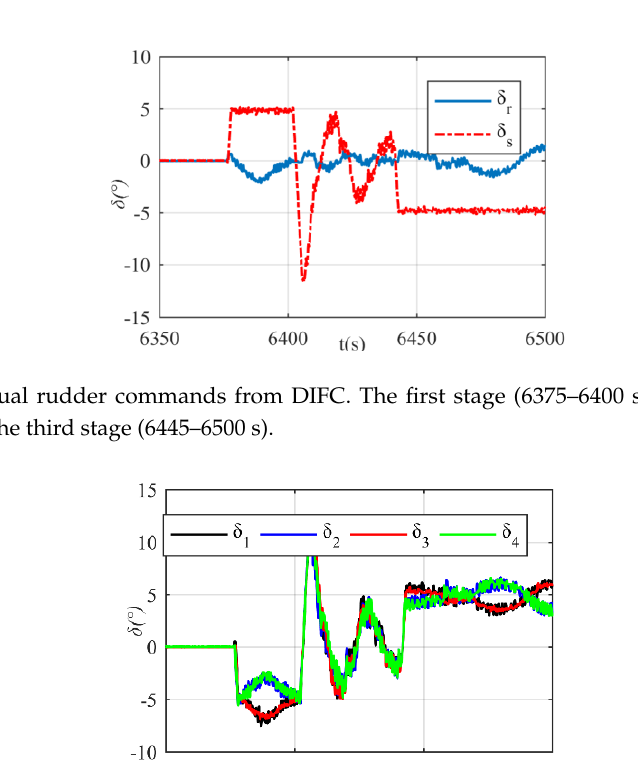
Figure 16. Evolution of errors in every loop. Errors in heading control (top) and errors in depth control (bottom).